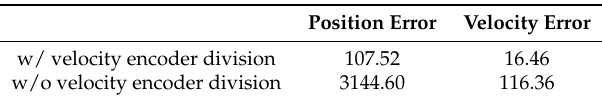
Table 5. Position error and velocity error of the proposed velocity encoder and the one that directly recognized the velocity without dividing into direction and